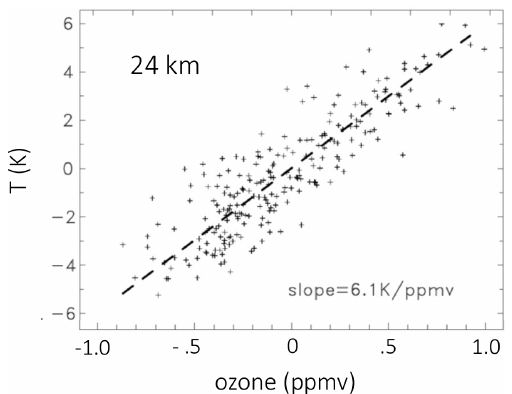
Figure 5. Scatterplot of deseasonalized temperature vs. ozone anomalies from SHADOZ data at 24km (data as in Fig.